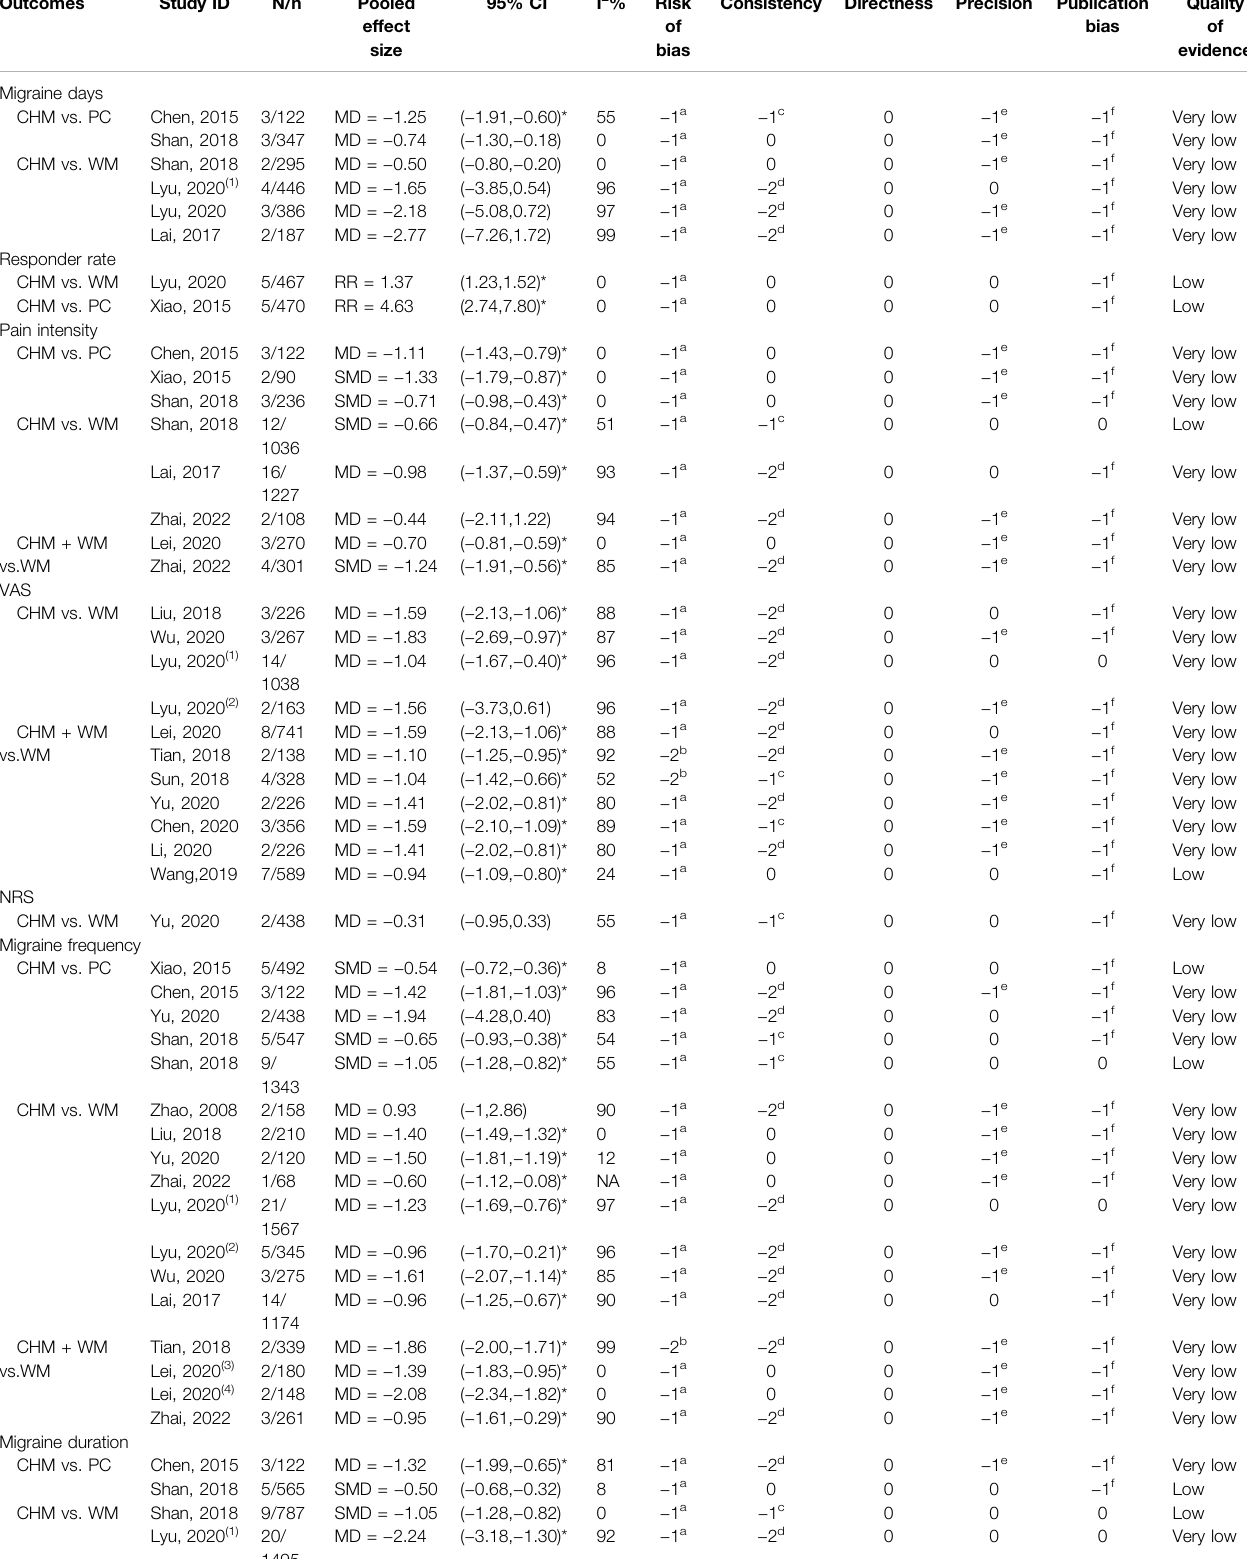
TABLE 7 | GRADE pro fi le for the quality of evidence. Outcomes